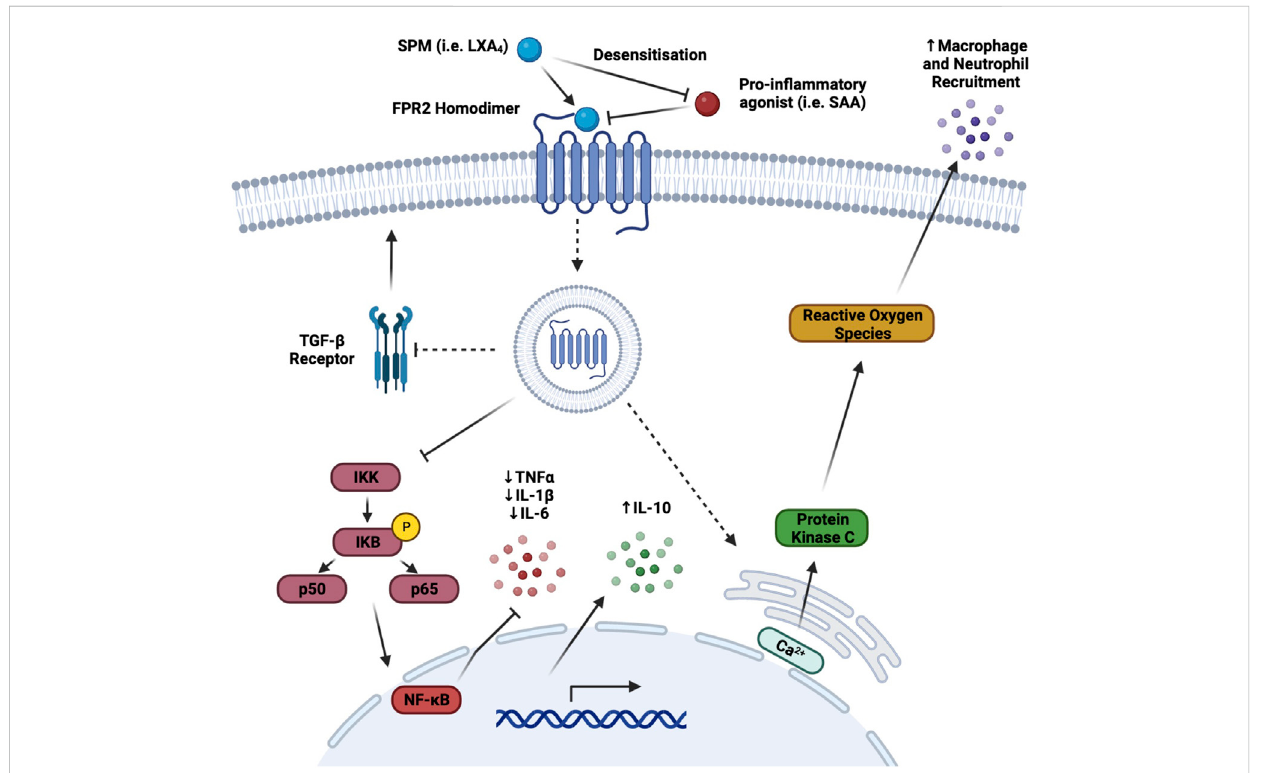
FIGURE 3 FPR2Signalling Pathways.The bindingoftheFPR2receptor agonist,LXA 4 , hasanumberofdifferenteffectswhichpromoteananti-in fl ammatoryor pro-resolving chain of events. As a receptor agonist, binding of LXA 4 to FPR2 prevents the binding of other pro-in fl ammatory mediators to the receptor via pro-in fl ammatory agonist desensitisation and subsequent internalisation. Downstream of this internalisation, NF- κ B is inhibited and as a result, pro- in fl ammatory cytokinetranscription and translation are reduced, thus attenuating their release. Furthermore, internal calcium free ions are released primarily through the endoplasmic reticulum stores. This increased intracellular calcium fl ux promotes the generation of ROS through protein kinase C activation. The production of ROS increases the conversion of circulating LDL to ox-LDL and thus augmenting macrophage and neutrophil attraction to thesiteofin fl ammation,whichinturnimprovesphagocytosisandefferocytosis.Finally,theTGF- β pathwayisinhibited via areductionintheexpressionof its receptor, TGF- β R, which plays a number of key roles, both athero-protective, and atherogenic, modulating the stiffening of arteries and blood vessels inlater stages of atherosclerosis.(Broken arrows/inhibitors indicate adownstream effect, whereas asolidarrow/inhibitor indicatesa direct effect)(Figure made with